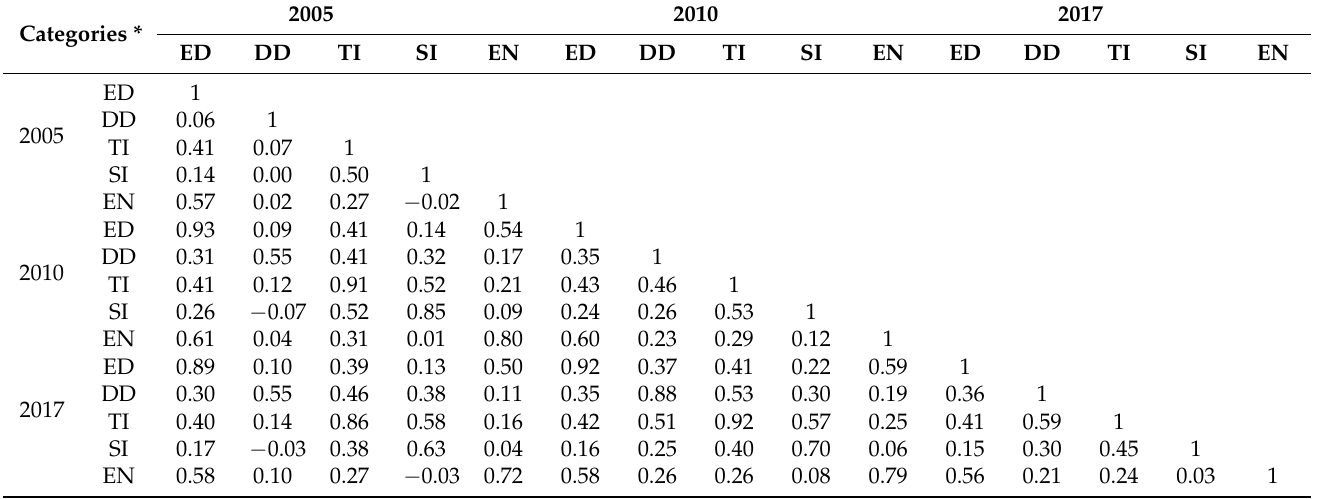
Table 4. Correlation coefficients of partial measures of development in 2005, 2010, and